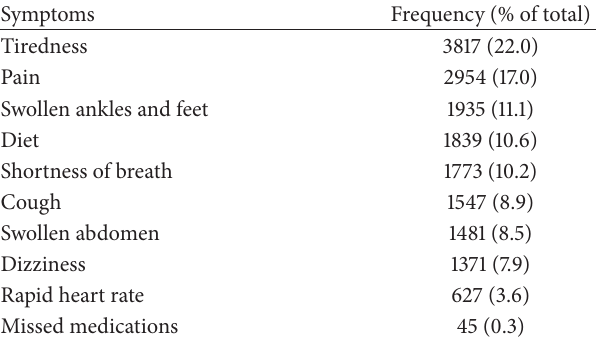
Table 1: Positive symptoms reported for the 100 patients enrolled in CCCP.